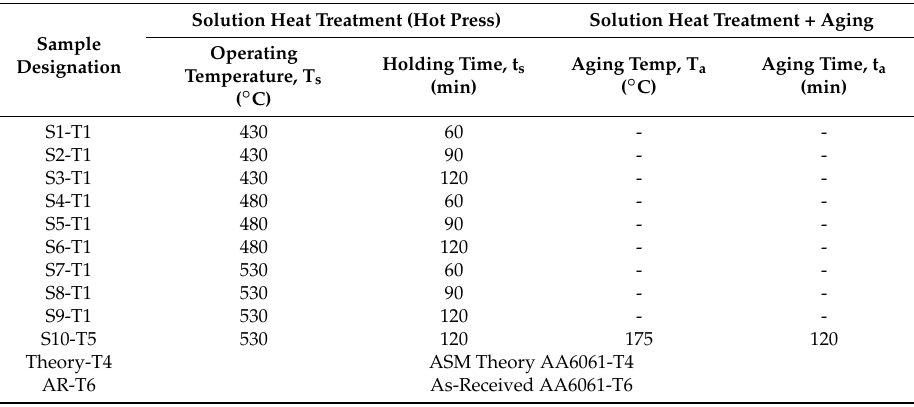
Table 2. Sample designation for different parameter setting.